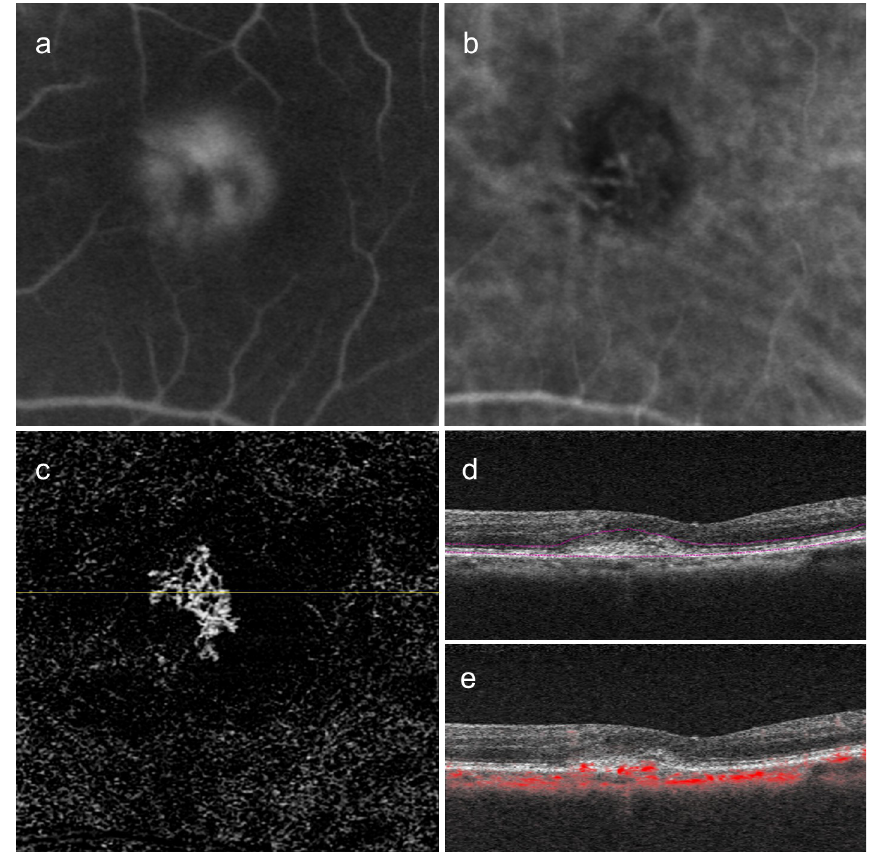
Fig 4. A case of Type 2 choroidal neovascularization (CNV). Left eye images of a 70-year-old female patient with a visual acuity of 20/25. (a) Mid-phase fluorescein angiography showing intense leakage and indicating a classic CNV